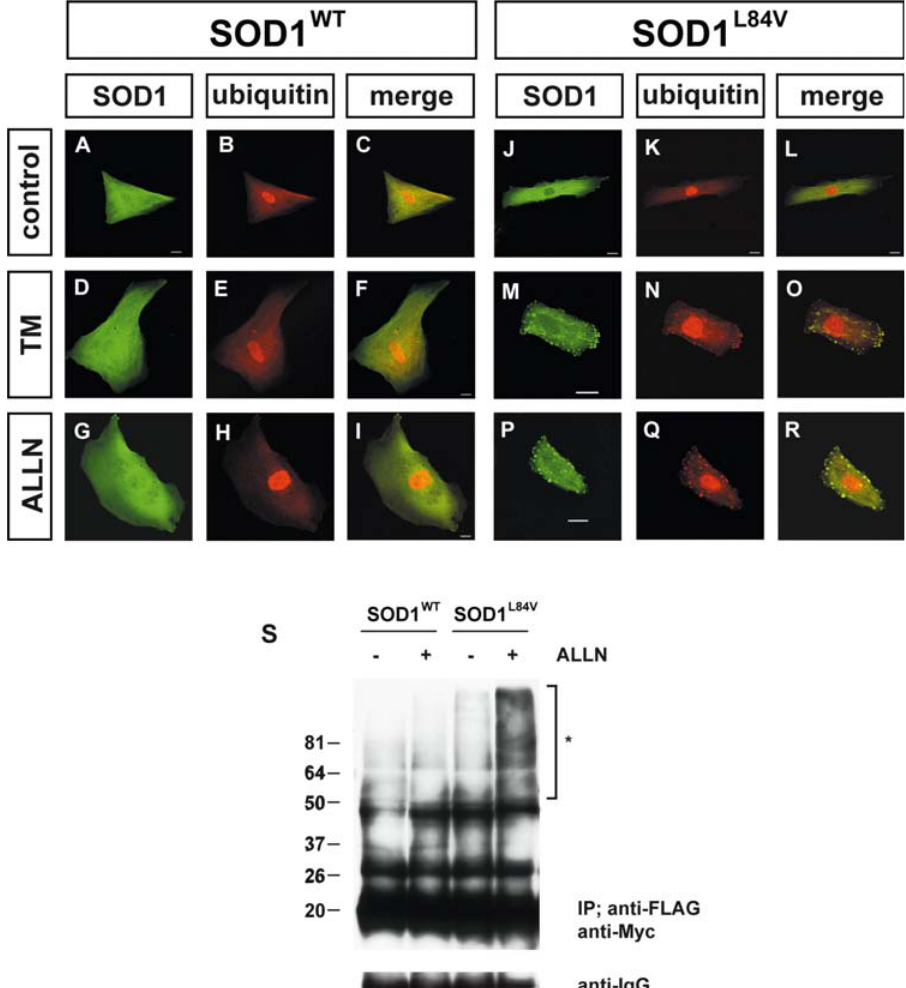
Figure 2. Ubiquitination of mutant SOD1 aggregates. ( A–R ) Colocalization assay with SOD1 and ubiquitin. SK-N-SH cells expressing wild-type SOD1 ( A–I ) or L84V SOD1 ( J–R ) were incubated with 1 m g/ml of tunicamycin ( D–F , M–O ), 4 m g/ml of ALLN ( G–I , P–R ), or no agents ( A–C , J–L ) for 24 h. Then the cells were fixed and stained with anti-SOD1 antibody (green; A , D , G, J , M , P ) or anti-ubiquitin antibody (red; B , E , H , K , N , Q ). Arrows indicate colocalization of SOD1 aggregates and ubiquitin. Scale bar=20 m m. ( S ) Co-immunoprecipitation assay utilizing ubiquitin. SK-N-SH cells stably expressing wild-type and L84V SOD1 were transfected with a myc-tagged ubiquitin expression vector. After incubation with or without ALLN, cell lysates were prepared and assayed with anti-myc antibody of the immunoprecipitant with anti-FLAG antibody. Asterisk shows an ubiquitinated ladder that appeared after ALLN treatment of L84V SOD1-expressing cells. IgG bands are shown as loading controls.